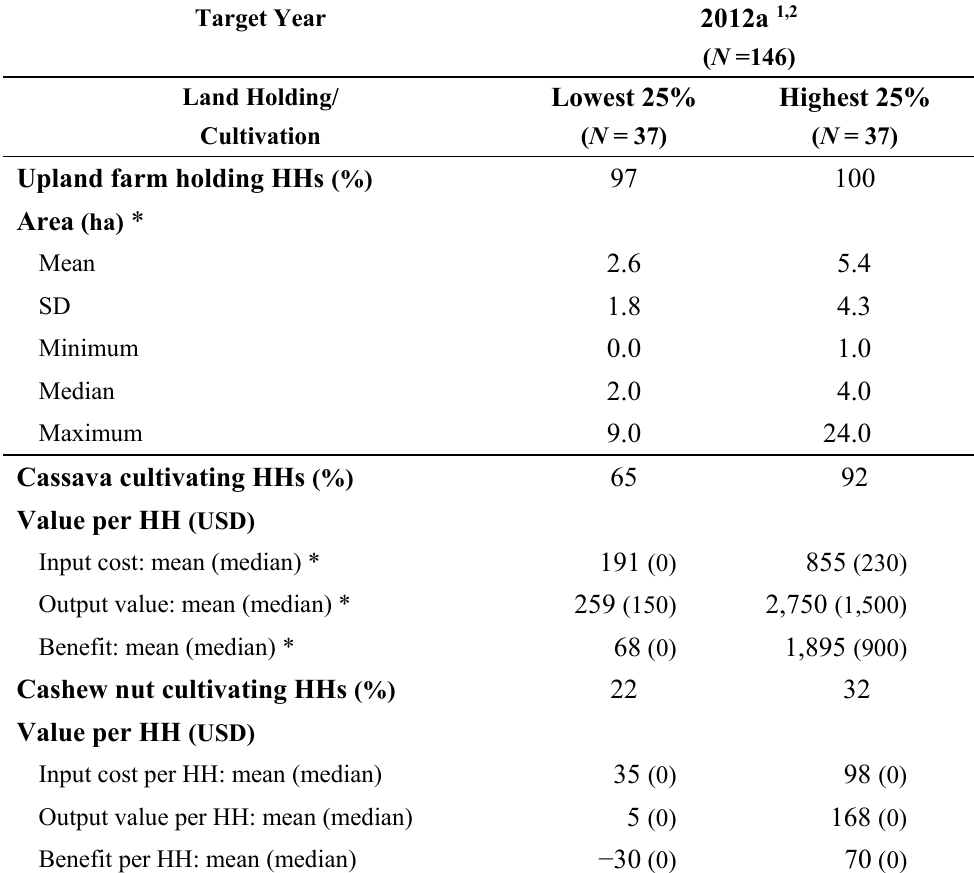
Table 5. Upland farm holdings and cultivation of two major cash crops in 2012 for the lowest and highest 25% of